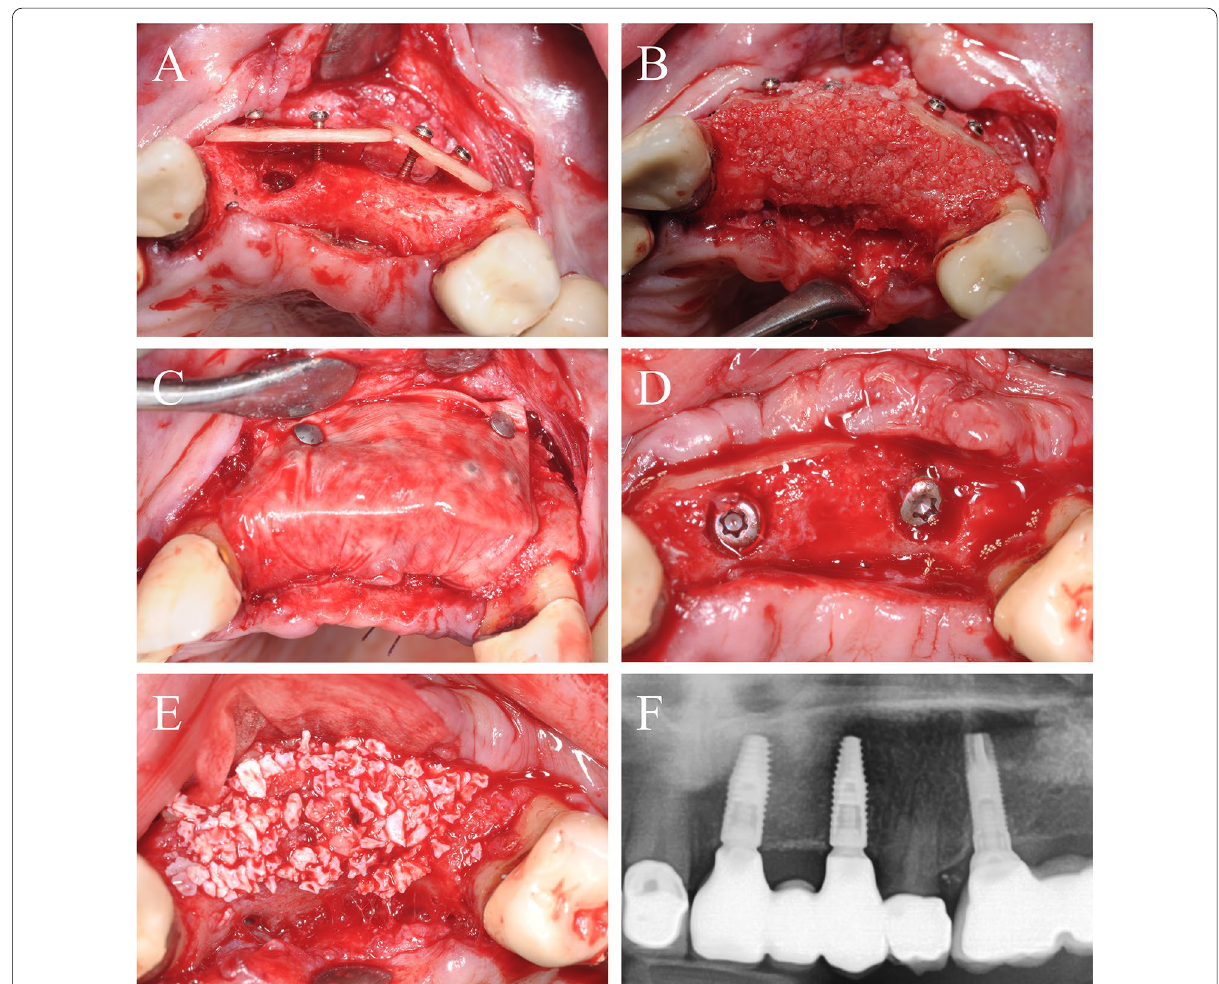
Fig. 4 Alveolar ridge augmentation of the anterior maxilla. A Initial intraoperative situation with an extended alveolar defect of the anterior alveolar jaw. Two allogeneic cortical bone plates were fixed by fixation screws. B Intraoperative situation after filling the defect with allogeneic spongious granules. C Covering the augmented area with a porcine collagen membrane. D Implant placement 4 months later. E Overlining with